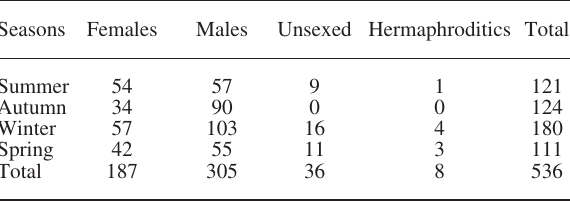
Table 2. – P. acarne specimens collected in the Gulf of tunis from June 2005 to July 2006.